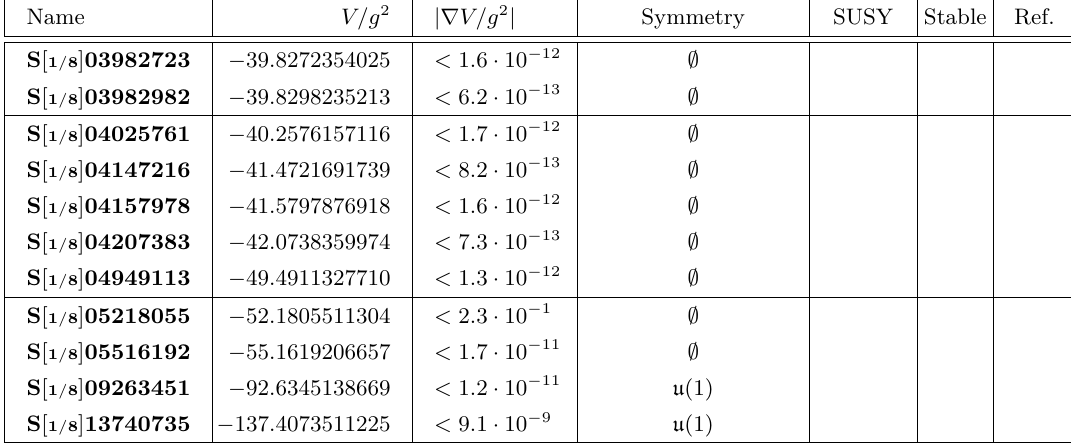
Table 1. Summary of vacua at ω = π/ 8